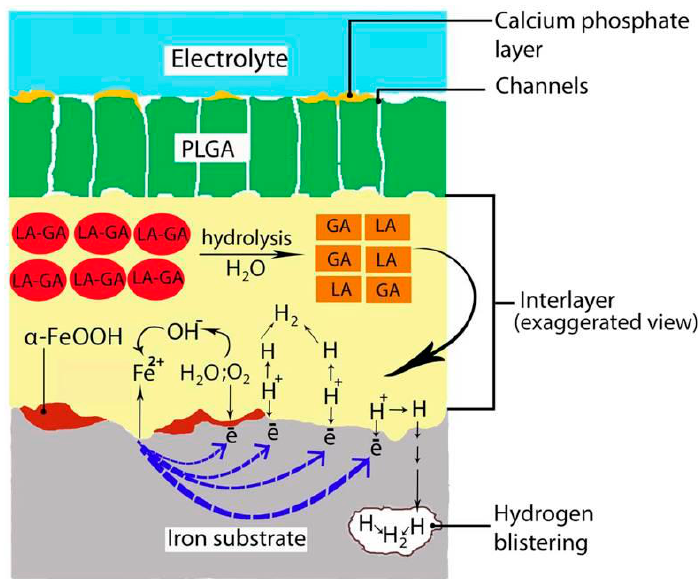
Figure 14. The proposed degradation mechanism at the iron/PLGA interface [101].